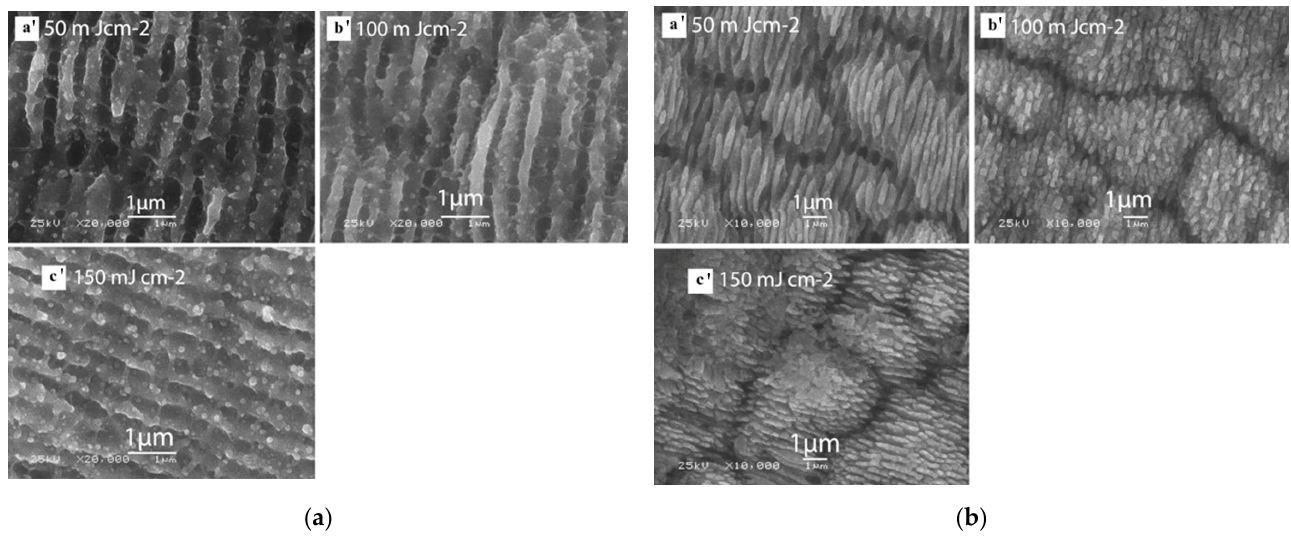
Figure 5. Ripple processing in air environment on AISI 304 stainless steel. ( a ) Center of ablation area with different fluence , ( a’ ) 50 mJ cm -2 ; ( b’ ) 100 mJ cm -2 ; ( c’ ) 150 mJ cm -2 ; ( b ) periphery of ablation area with different fluence, ( a’ ) 50 mJ cm -2 ; ( b’ ) 100 mJ cm -2 ; ( c’ ) 150 mJ cm -2 . “Reprinted with permission from Ref. [38], Copyright (2013), Springer Nature”.